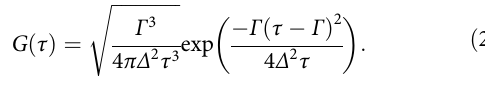
Gaussian function (IG-TTD) 25 , which is de fi ned by its fi rst two